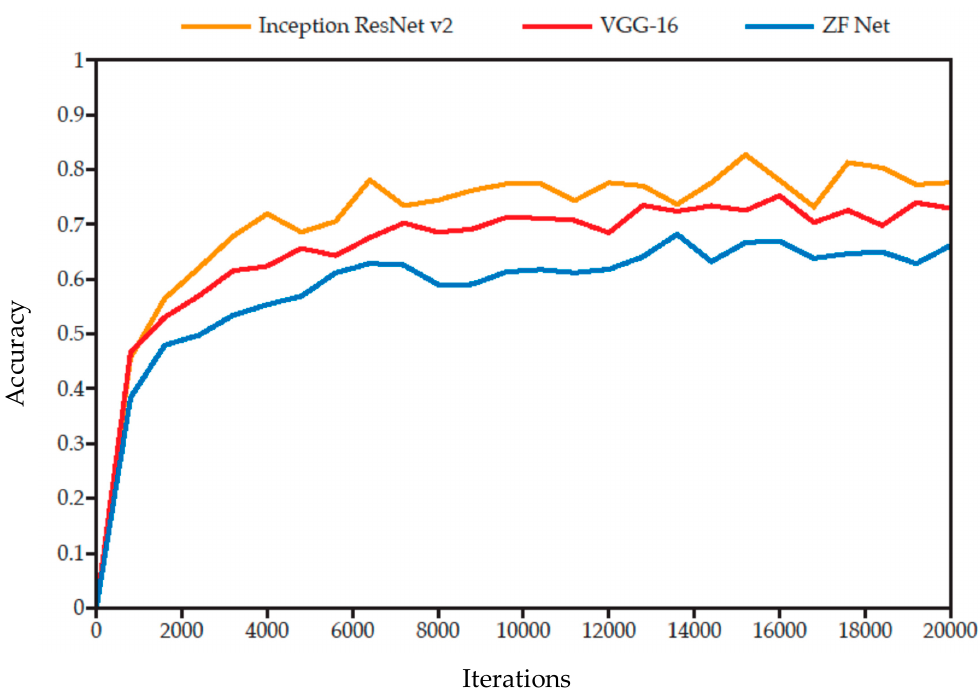
Figure 10. The validation accuracy of three CNN substructures.